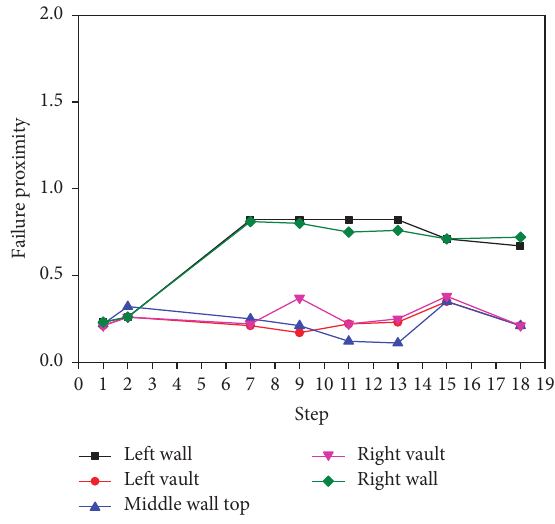
Figure 15: Displacement of scheme III. Figure 16: Failure proximity of scheme I.